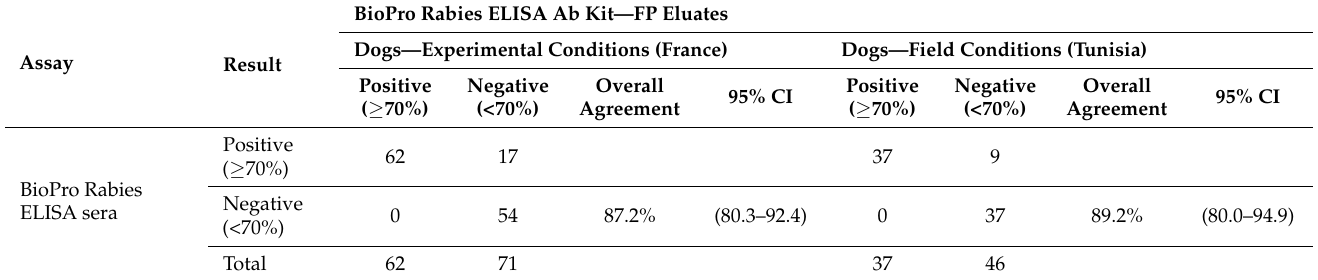
Table 2. FP eluates titrated using the BioPro ELISA kit versus sera titrated using the BioPro ELISA